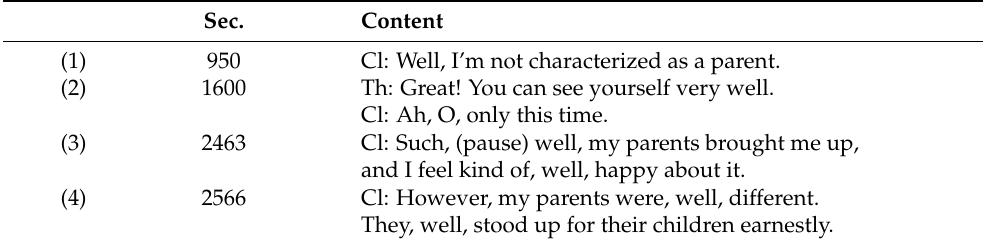
Figure 3. Nodding counts for the therapist (Th) and client (Cl) during the first dialogue. The bars represent the counts and the line corresponds to the eleven-point average values. The numbers in parentheses correspond to the numbers in Table 2. Table 2. Contents of interactions in the first dialogue highlighted by the analysis (Therapist: Th, Client: